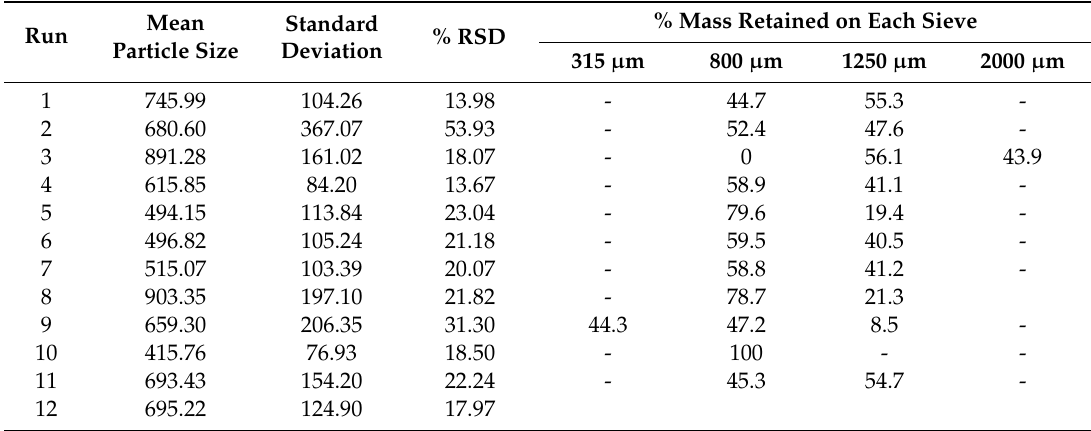
Table 12. Mean particle size and size distribution of INH microspheres following sieve analysis. Run